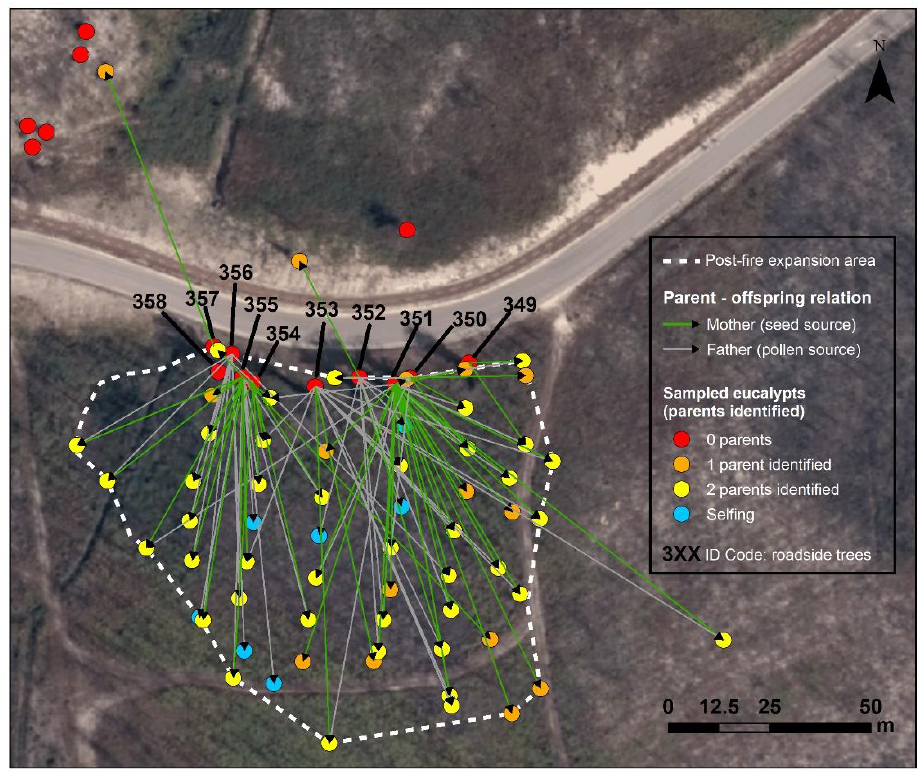
Figure 3. Distribution of sampled eucalypts featuring results from paternity assignment. When two parents were assigned, the closest parent was assumed to be the seed parent, and the farthest was assumed to be the pollen parent.